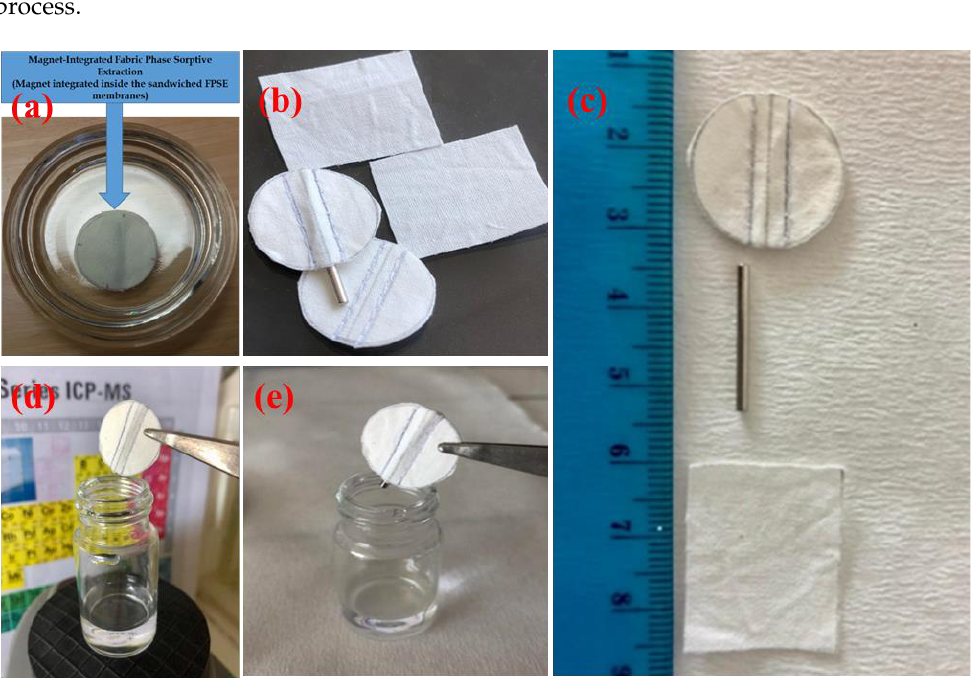
Figure 1. Fabric phase sorptive extraction and magnet integrated fabric phase sorptive extraction (MI-FPSE) membranes: ( a ) image of an MI-FPSE membrane; ( b ) side-by side images of classical FPSE membranes and MI-FPSE membranes; ( c ) size comparison between classical FPSE membrane and MI-FPSE membrane; ( d ) extraction operation of MI-FPSE; ( e ) desorption operation in MI-FPSE.